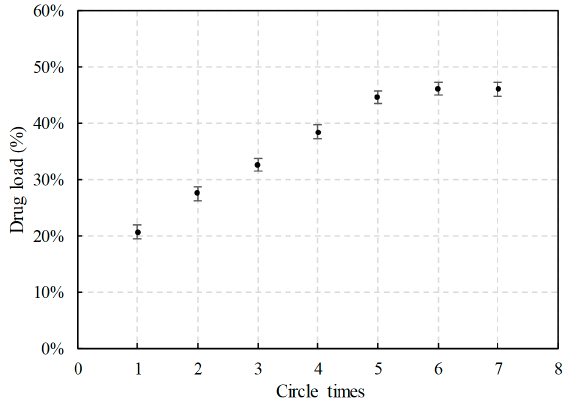
Figure 2. Drug load of CEO@MCM-41 prepared under different circle times by modified supercritical impregnation.